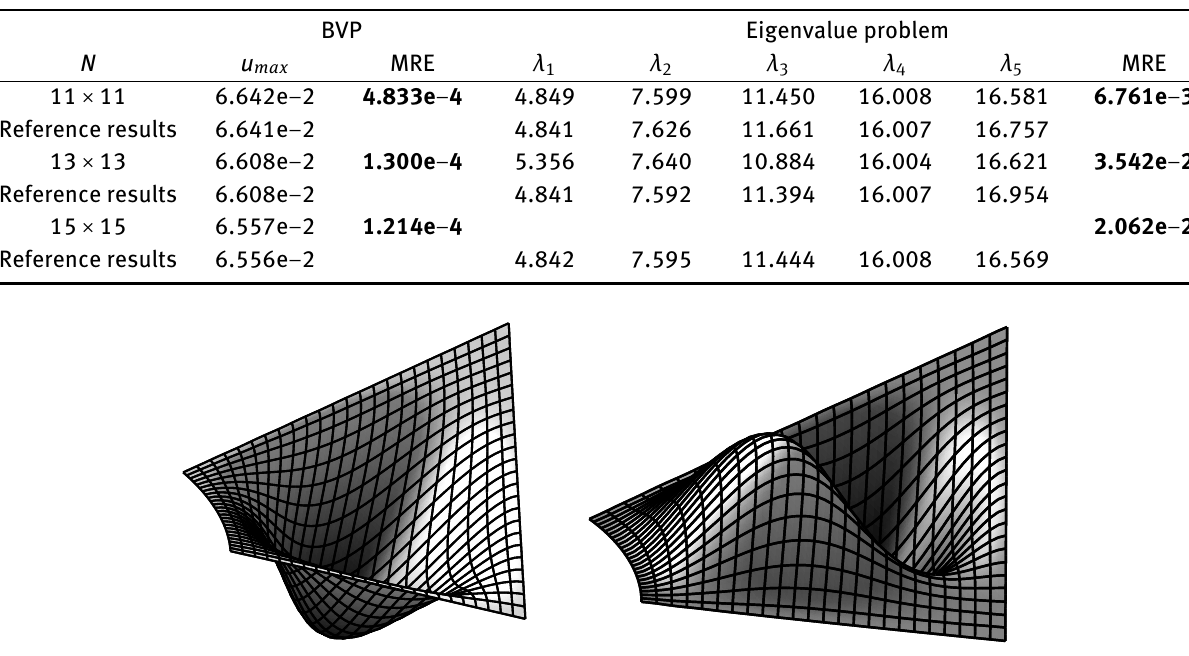
Figure 7: The first (left) and the second (right) vibration mode for the clamped triangular plate with corner cut-out.